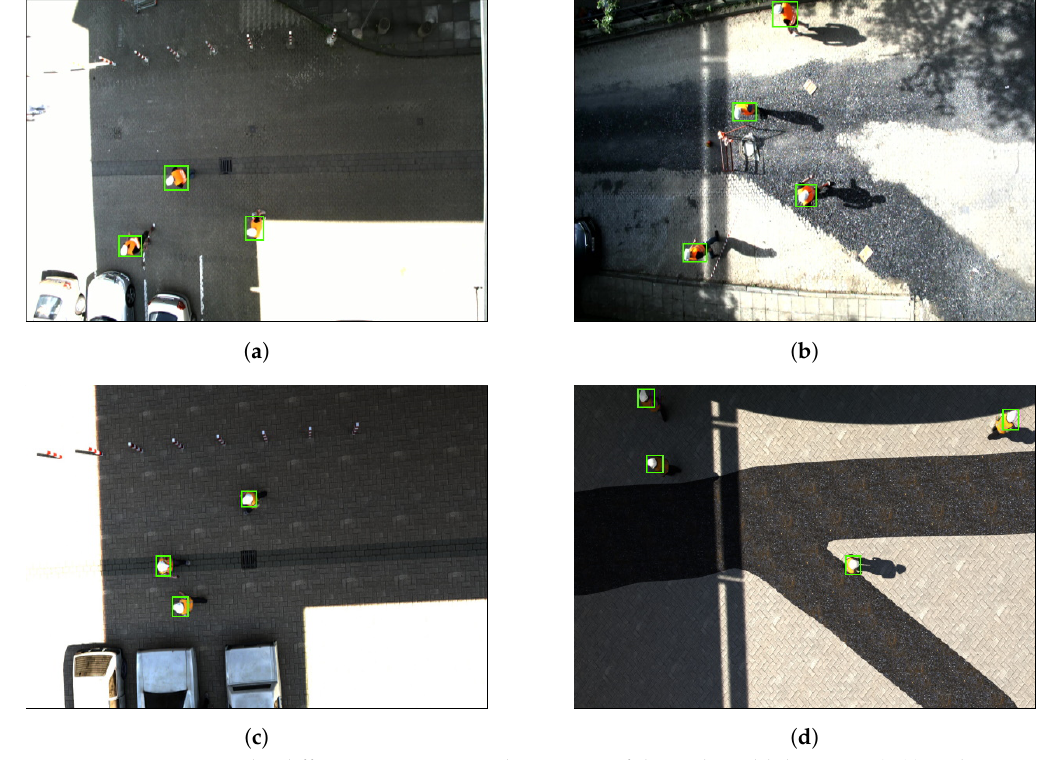
Figure 1. Comparing the different environmental scenarios of the real world dataset in ( a , b ) to their 3D generated counterparts in ( c , d ), respectively. Ground truth labels are marked as green